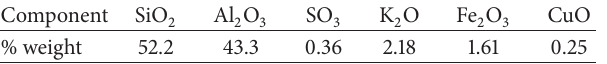
Table 1: Chemical composition of clay at Ranong province.